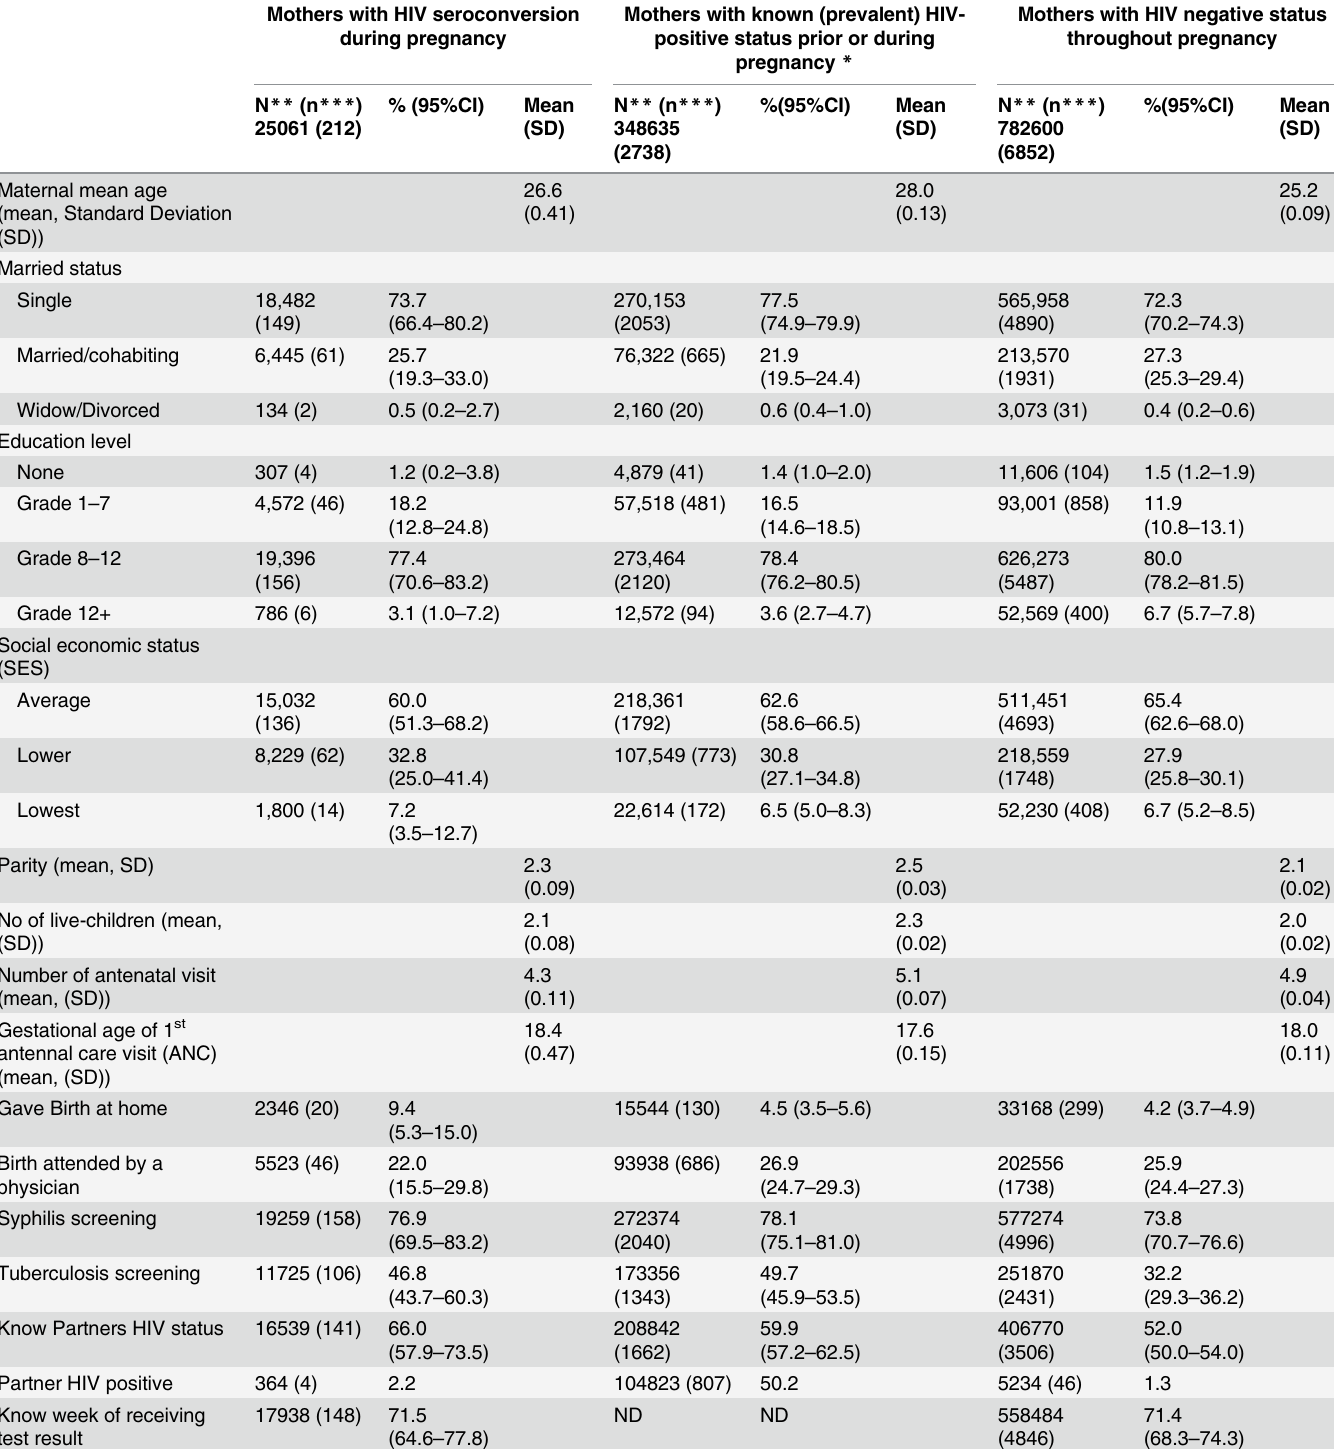
Table 1. Socio-demographic characteristics of participating mothers and infants by maternal HIV status during pregnancy, South Africa, 2011 – 2012. Mothers with HIV seroconversion Mothers with known (prevalent) HIV- Mothers with HIV negative status during pregnancy positive status prior or during throughout pregnancy *